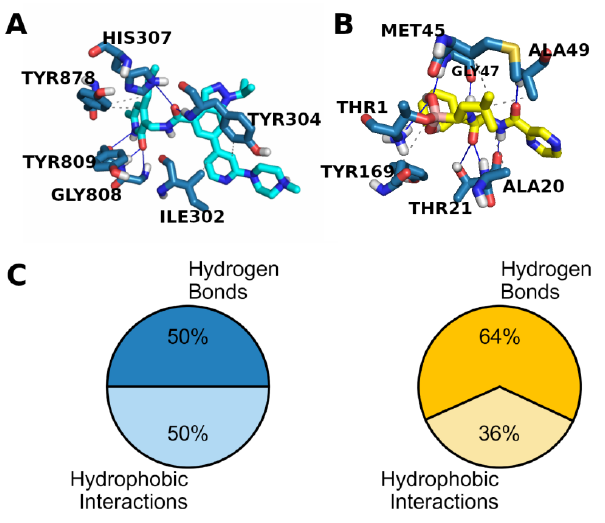
Figure 9. Interaction profile in the pockets of EZH2 (5WFC) and P20S (5LF3) X-ray structures (hydrogen bonds are marked by a blue line and hydrophobic interactions by a grey dashed line); ( A ) protein–ligand interactions between EZH2 and its X-ray ligand GSK343 (cyan); ( B ) protein– ligand interactions between P20S and its X-ray ligand bortezomib (yellow); and ( C ) distribution of interaction types found in EZH2 (5WFC) and P20S (5LF3) X-ray structures, shown in blue and yellow pie charts, respectively.